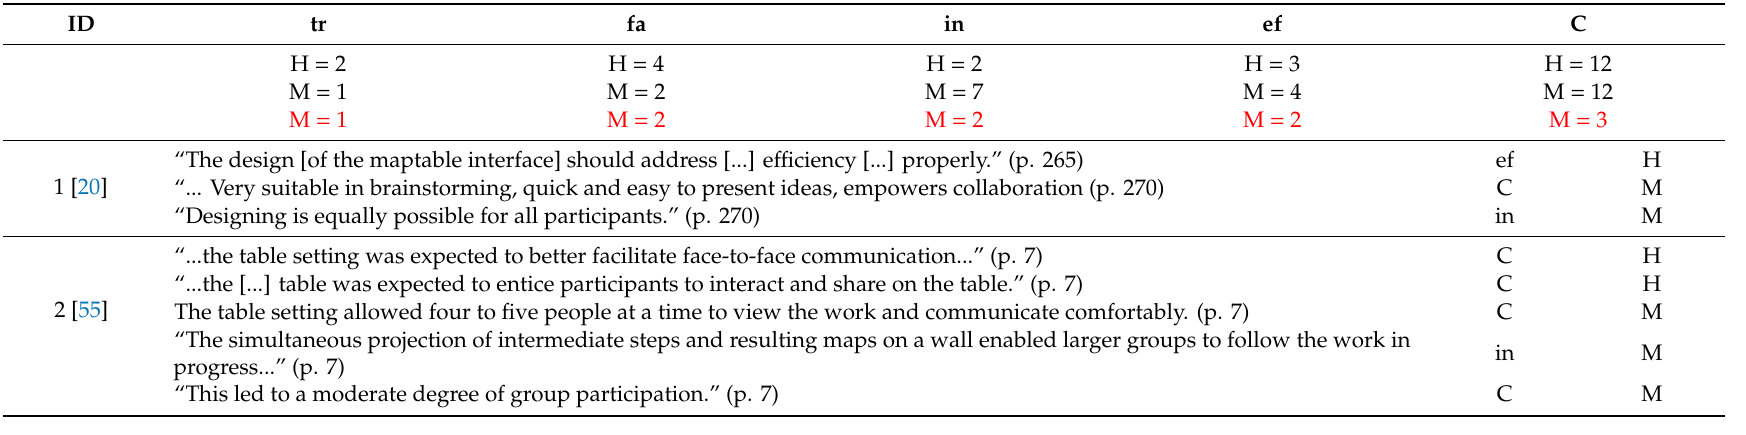
Table A4. Communication and